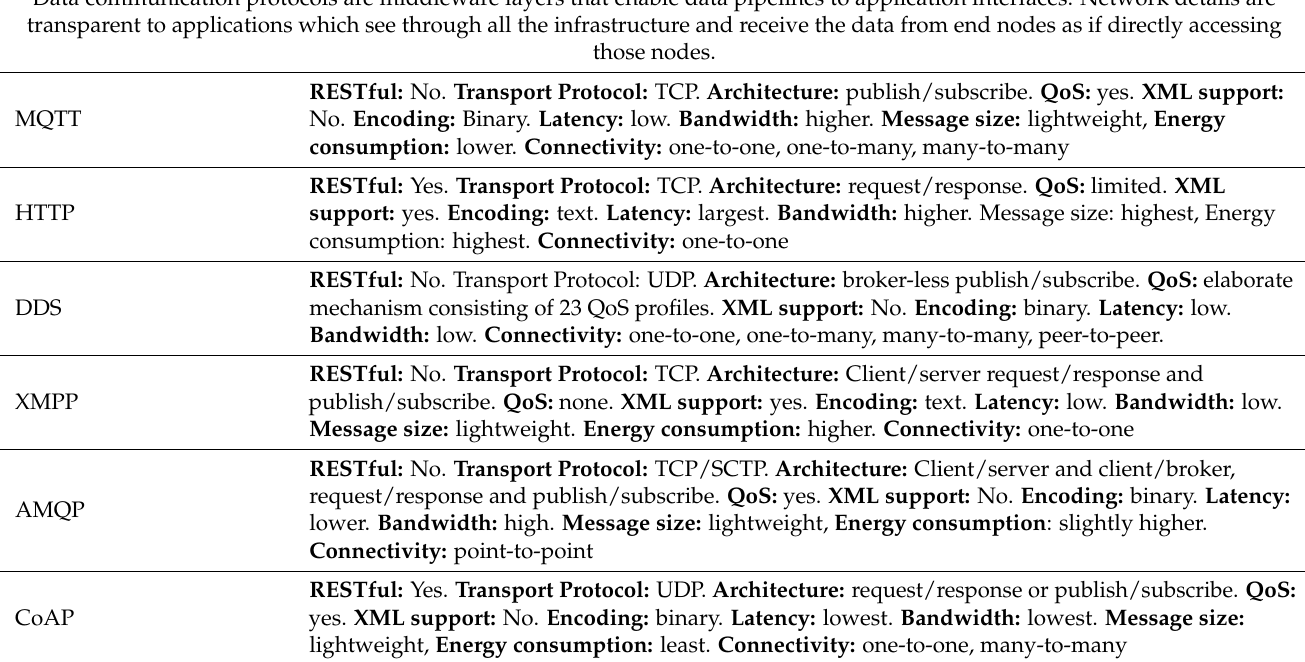
Table 8. Cont. Protocol Details Protocols for data